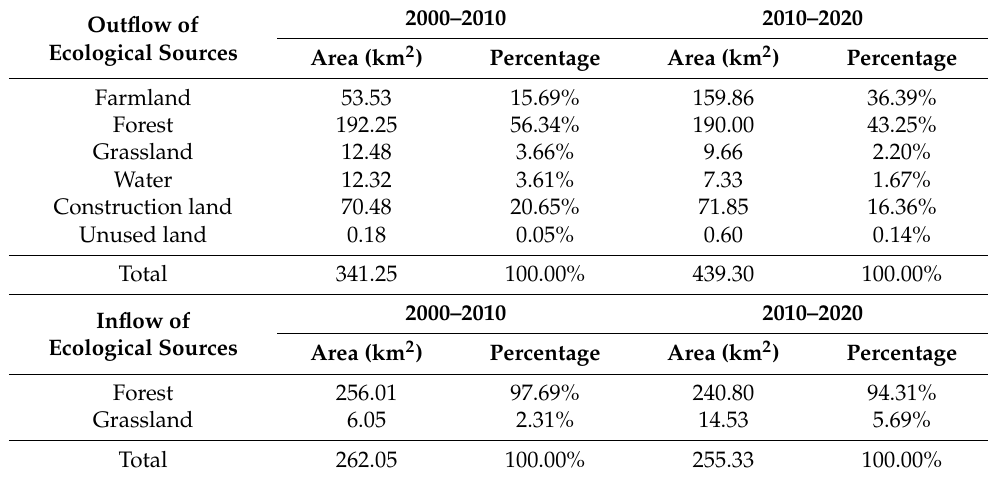
Table 1. Outflow and inflow of ecological sources from 2000 to 2020. Outflow